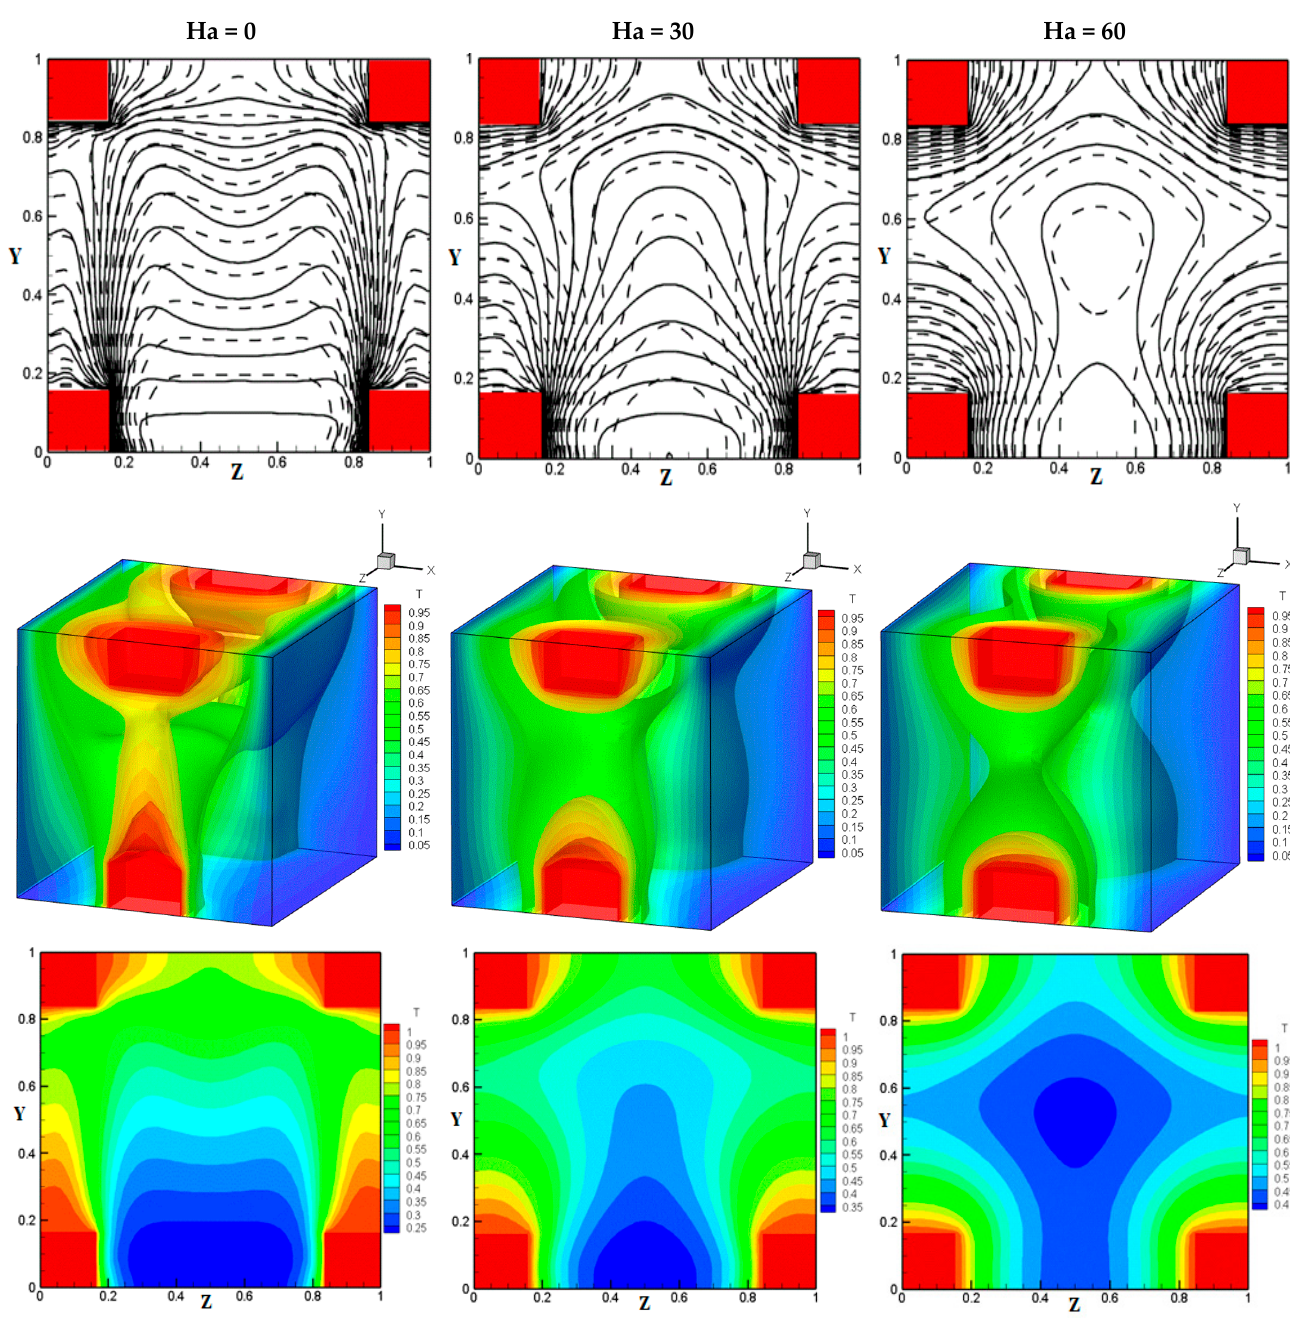
Figure 4. Flow ( top ) and thermal ( bottom ) structures inside the cavity for various values of the Hartmann number at [ φ = 0 (solid line), φ = 0.04 (dash line) and Ra = 10 5 ] and (d p = 10 nm).